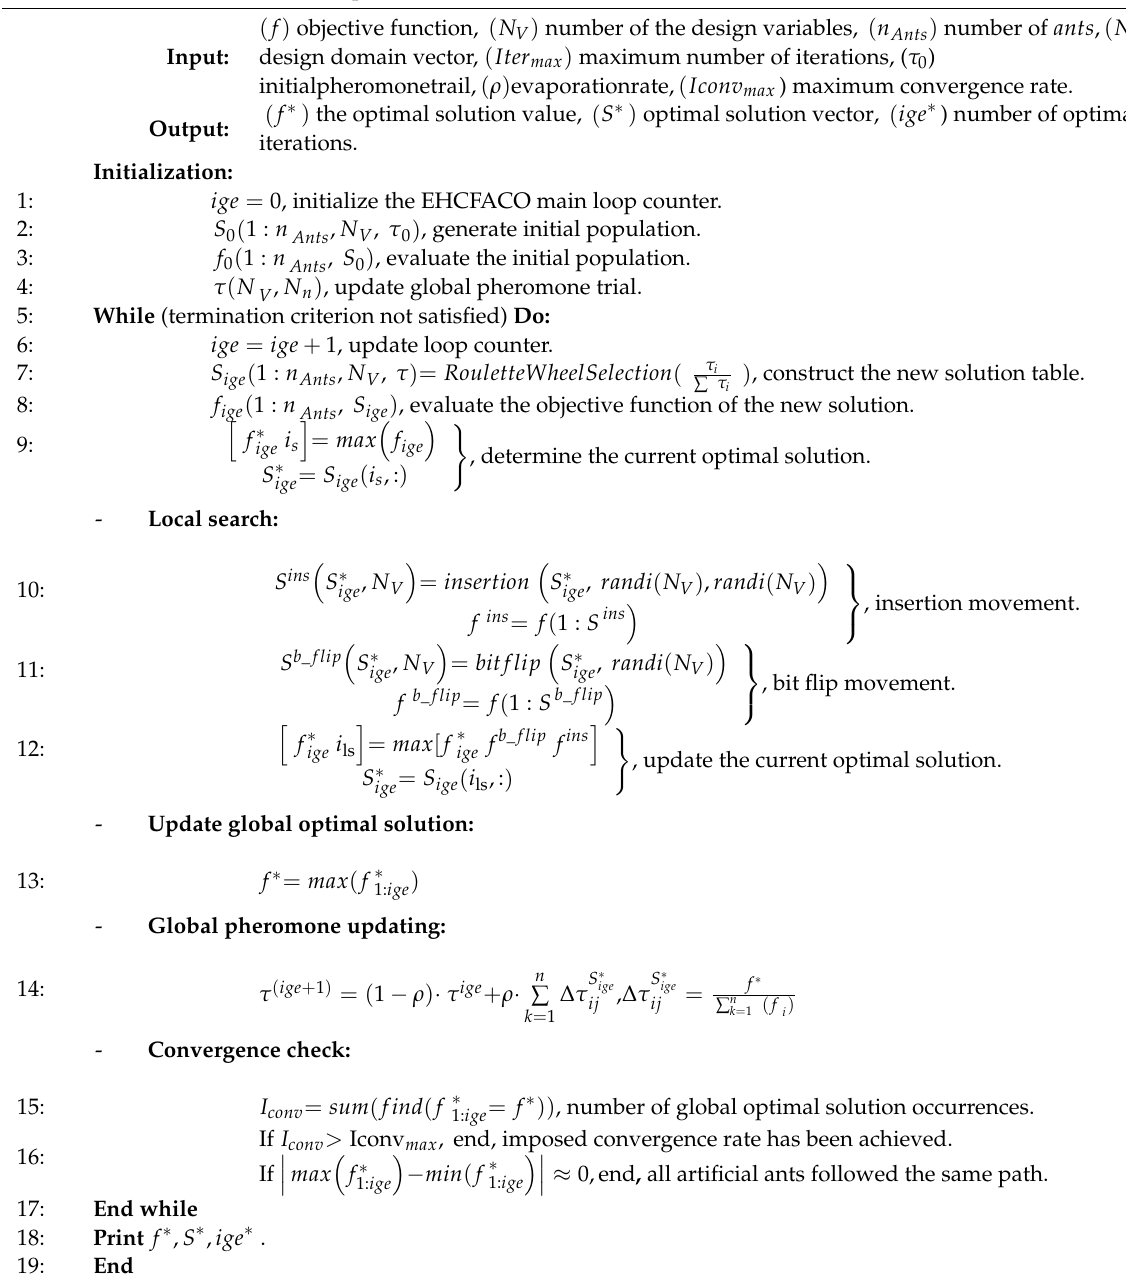
Algorithm 2 Enhanced HCFACO